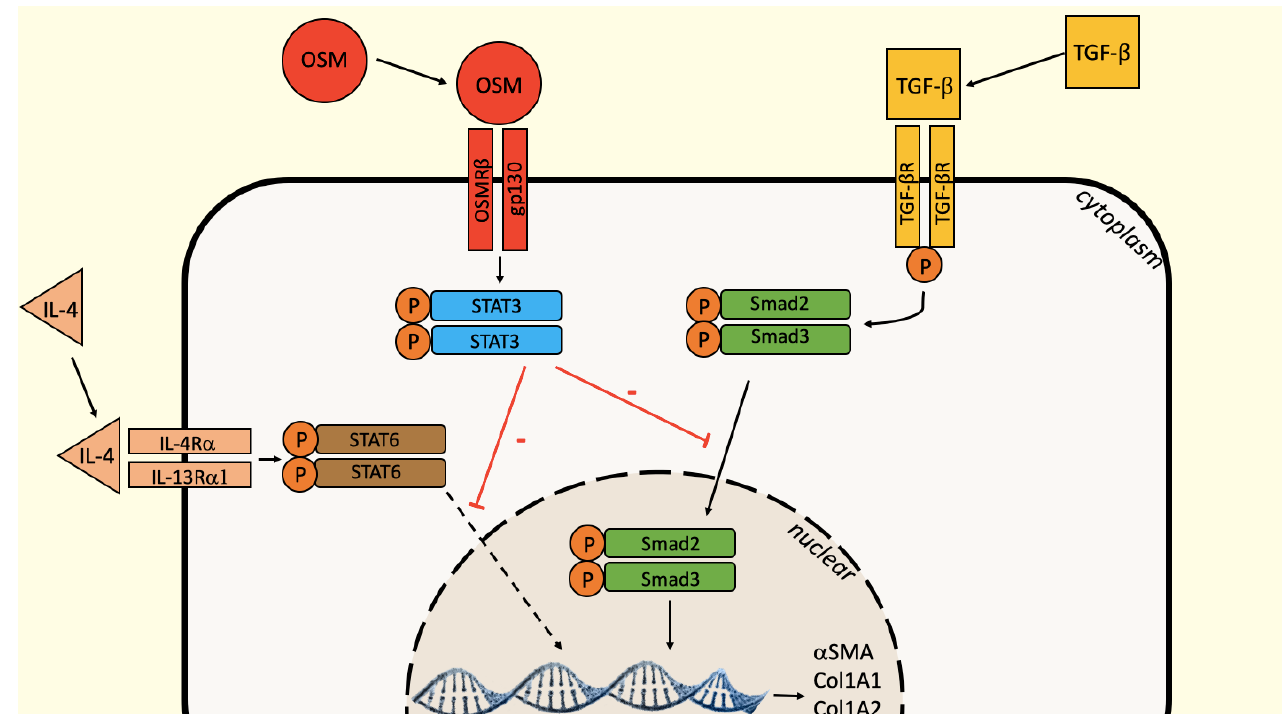
Figure 4. Summary of TGF- β 1, IL-4 and OSM integrated effects on fibrosis and differentiation in CRSwNP.